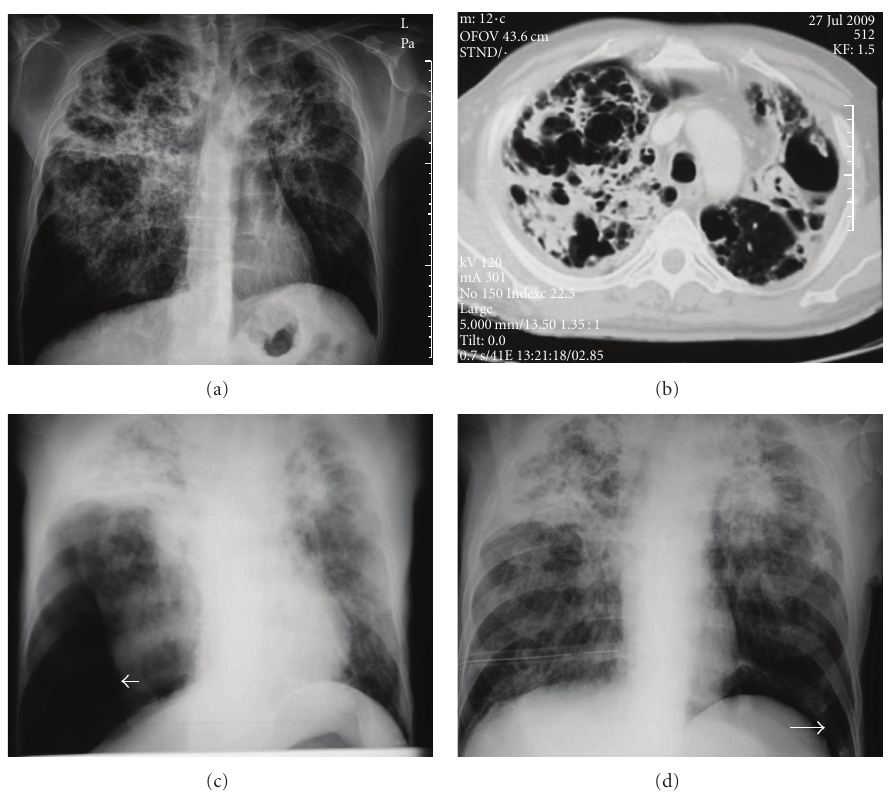
Figure 2: Almost one year prior to his admission he was presented with weight loss, fever, and dyspnea and pulmonary tuberculosis due to mycobacterium avium infection was diagnosed. One month after a bilateral pneumothorax (arrows) was diagnosed and pleurodesis was performed.